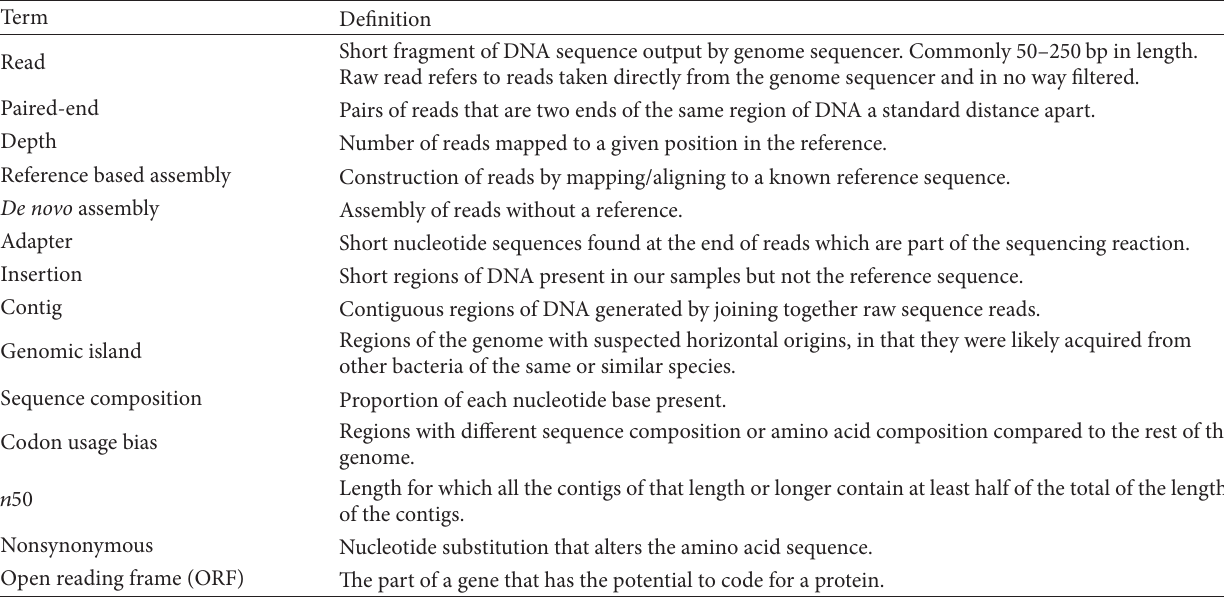
Table 1: Glossary of genomics and bioinformatics